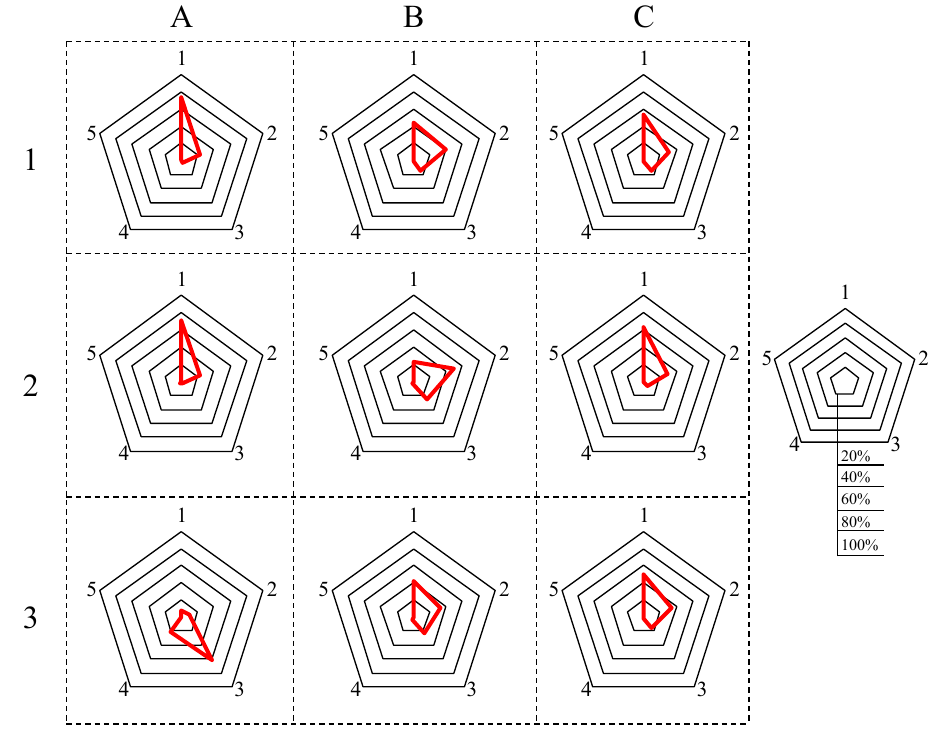
Figure 15. The percentage of building form distribution with optimization of higher than 85% of acceptable UTCI percentage at street level.